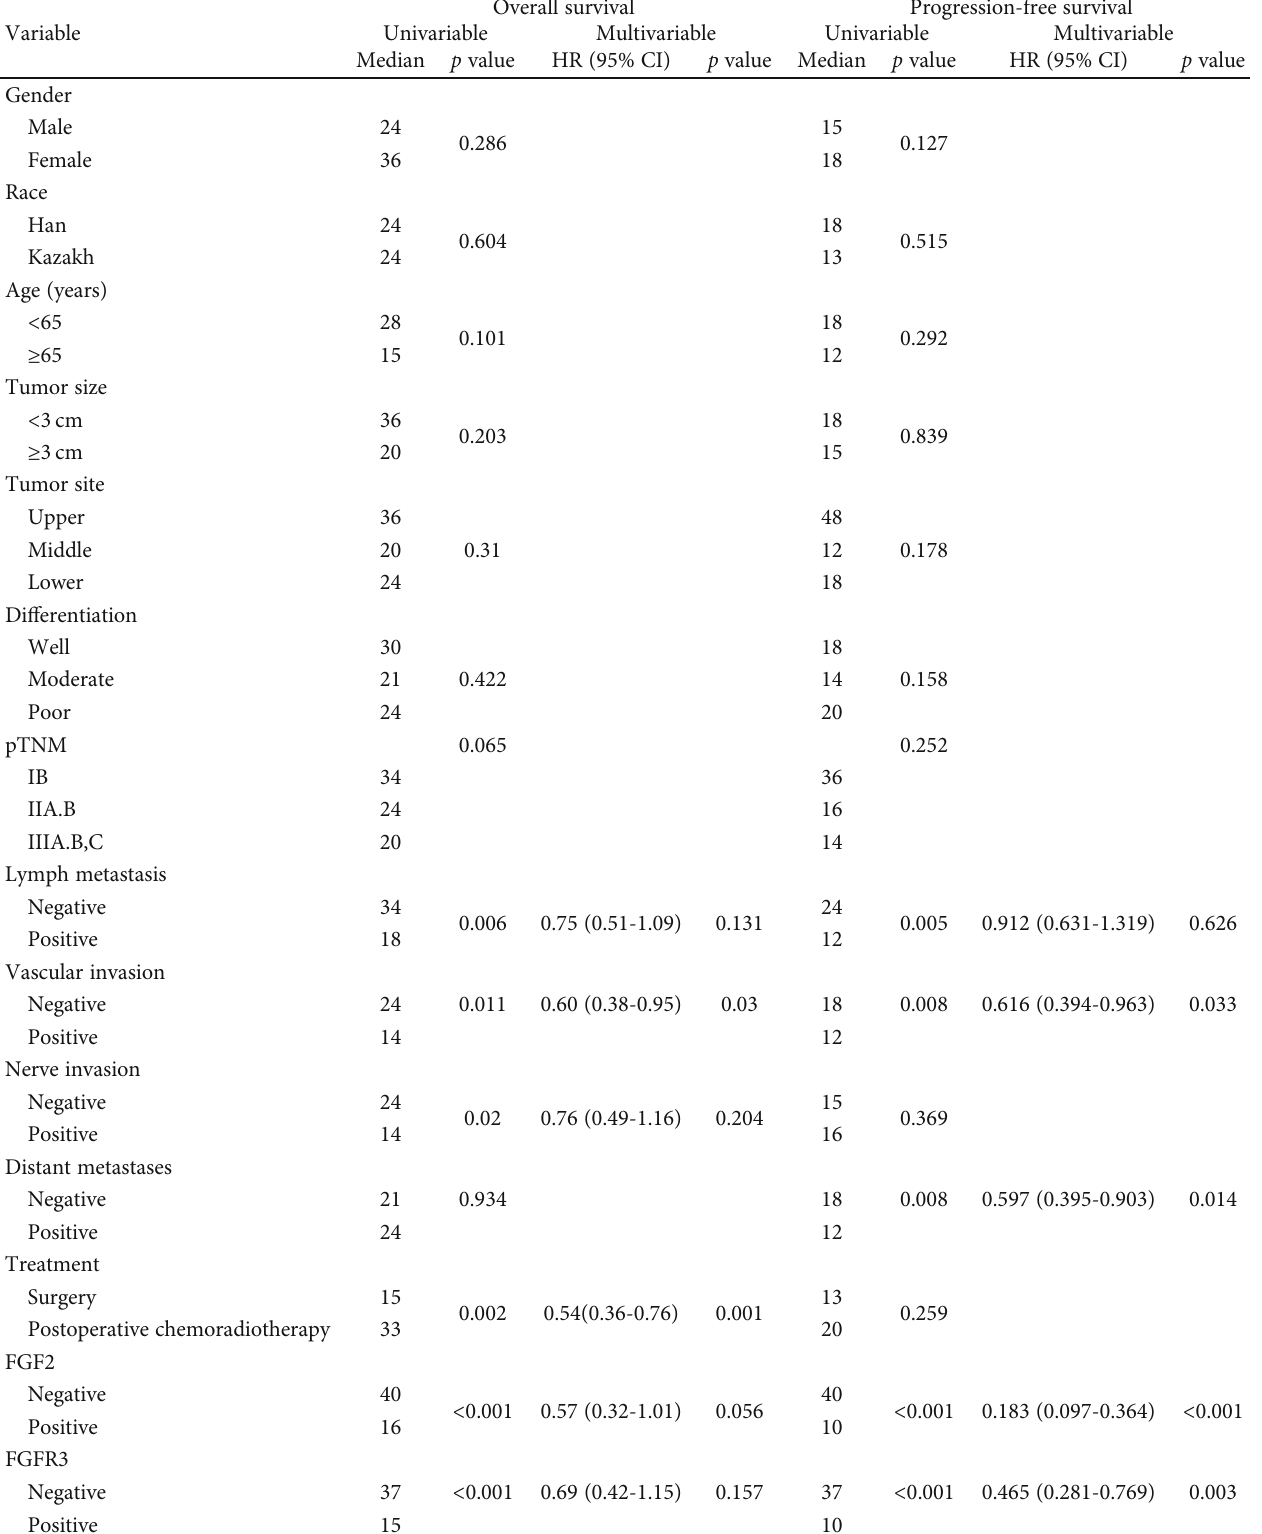
Table 6: Univariable and multivariable analyses for overall survival and progression-free